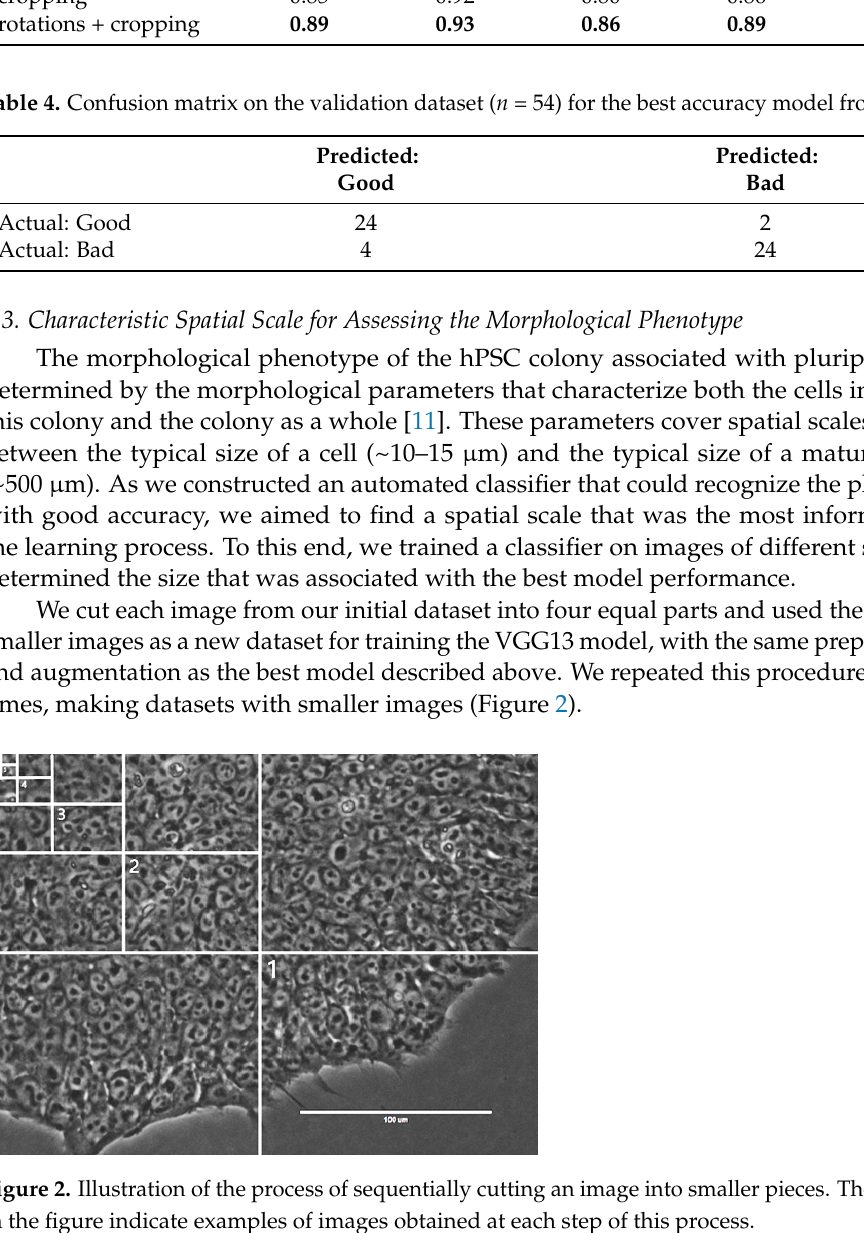
Figure 3. Two quality measures (accuracy and F1-score) shown on the validation set by the VGG13 model trained on images of different sizes. The maximum values are reached at ~144 μ m. 2.4. Proteome Analysis in H9 Cells with Good and Bad Phenotype To reveal whether the H9 colonies with good and bad morphological phenotypes under self-renewal conditions differ at the molecular level, we analyzed the proteomic data of eight samples, consisting of good clonal undifferentiated colonies (good pheno- type, 3 samples), clonal colonies with signs of spontaneous differentiation (bad pheno- type, one sample), and non-clonal colonies with differentiated cells (bad phenotype, four samples; bulk cultures). The cell cultures for clonal and bulk expansion were propagated as described in Ref. [11].